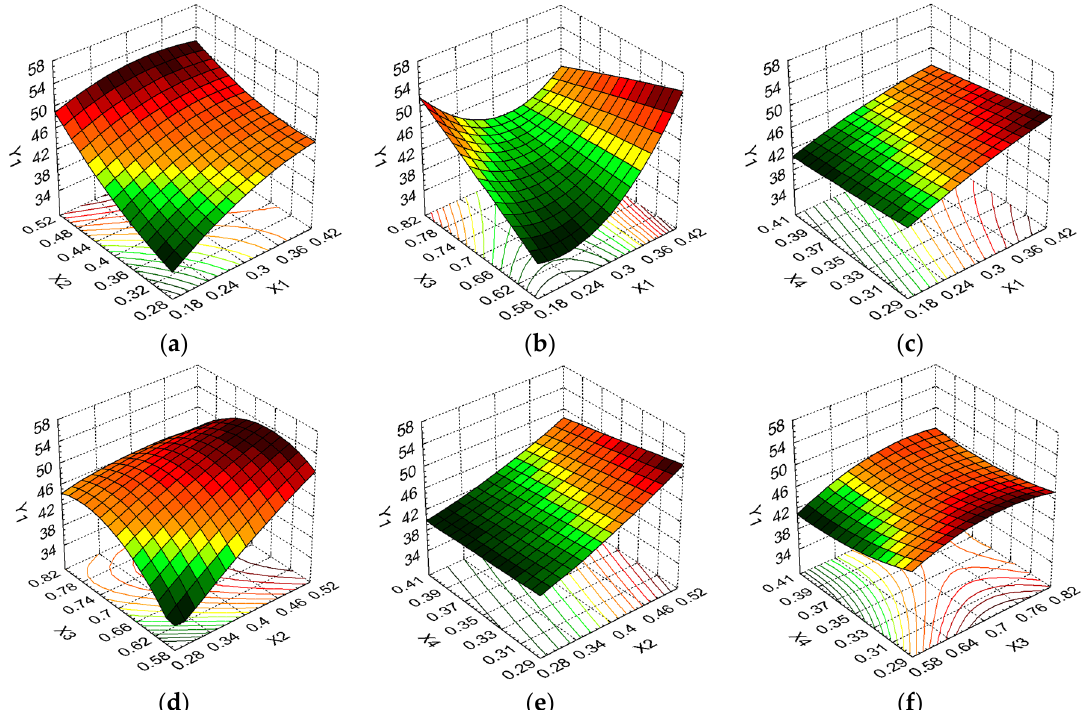
Figure 5. The 3D response surface and contour plot showing the effect of different formulation factors on the microcapsule diameter ( Y 1 ): ( a ) collagen concentration ( X 1 ) and NaCMC concentration ( X 2 ); ( b ) collagen concentration ( X 1 ) and sodium alginate concentration ( X 3 ); ( c ) collagen concentration ( X 1 ) and doxycycline concentration ( X 4 ); ( d ) NaCMC concentration ( X 2 ) and sodium alginate concentration ( X 3 ); ( e ) NaCMC concentration ( X 2 ) and doxycycline concentration ( X 4 ); ( f ) sodium alginate concentration ( X 3 ) and doxycycline concentration ( X 4 ).